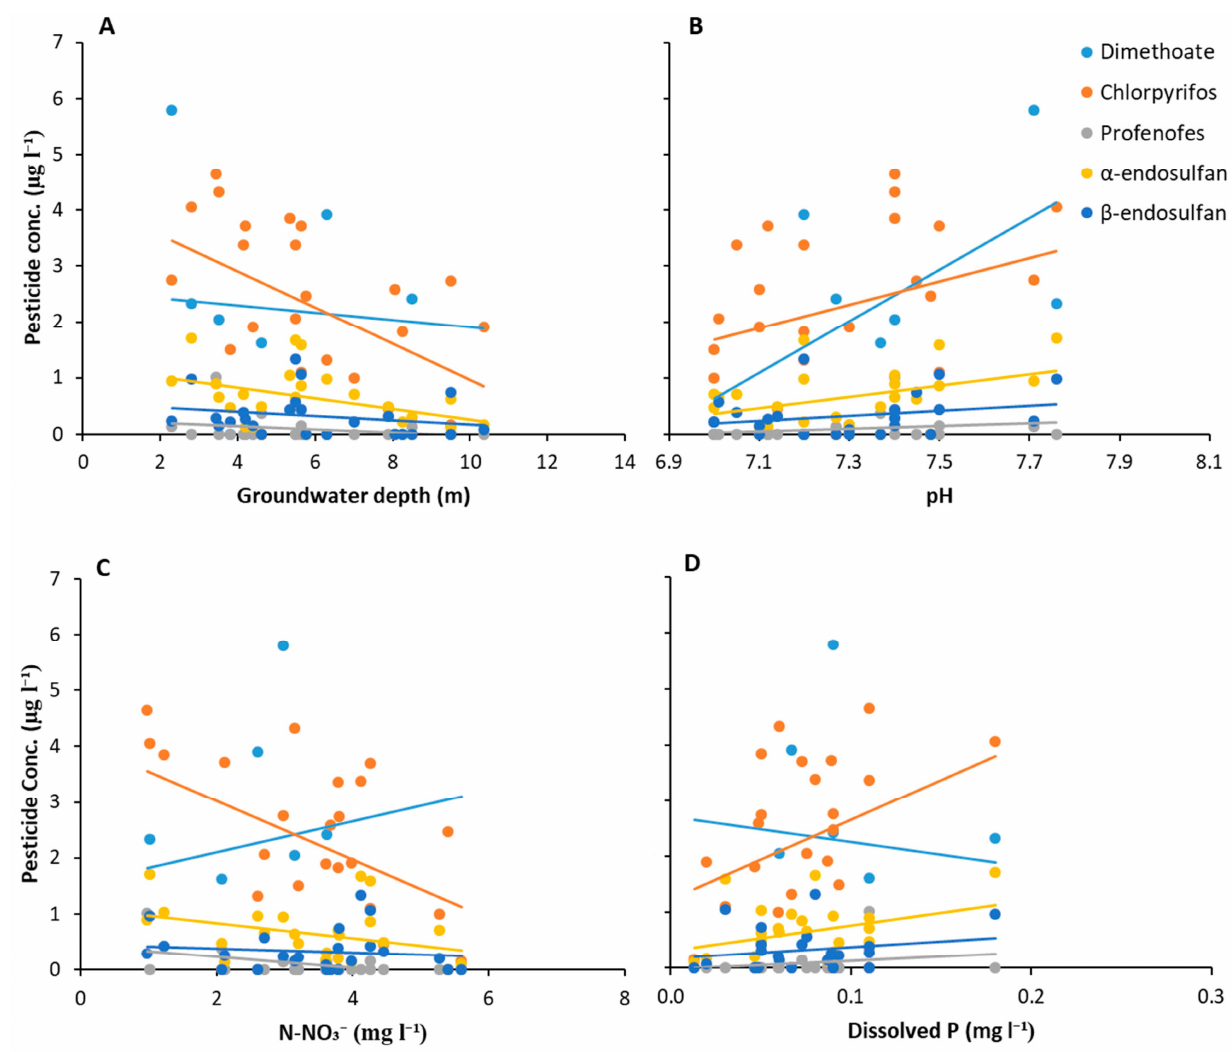
Figure 5. Pesticide concentration in groundwater as a function of groundwater depth, pH, dissolved phosphorus, and nitrate concentrations. The regression lines have the same color as the symbols. The statistics of the regression lines are provided in Table